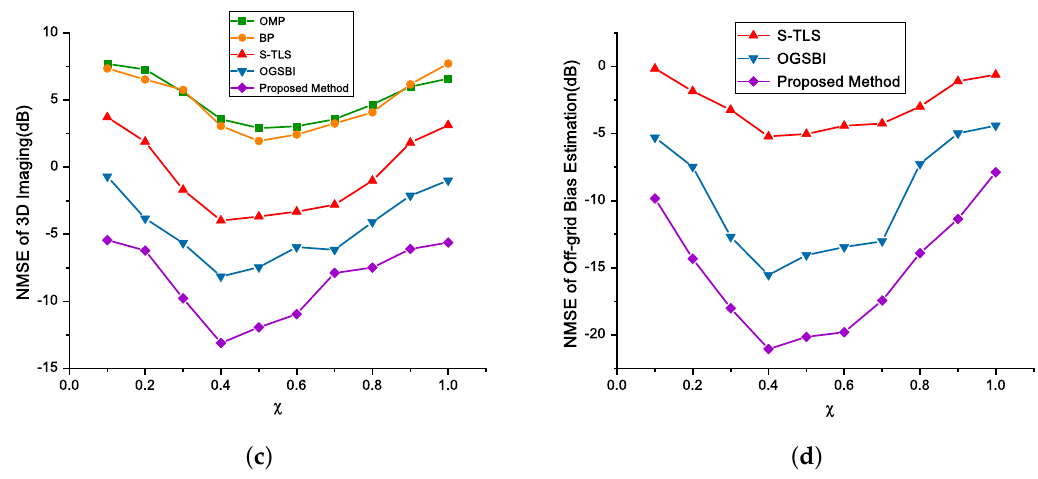
Figure 5. NMSEs versus different SNRs and grid invervals: ( a ) NMSEs of 3D reconstruction versus different SNRs; ( b ) NMSEs of off-grid bias estimations versus different SNRs; ( c ) NMSEs of 3D reconstruction versus different grid intervals; ( d ) NMSEs of off-grid bias estimations versus different grid intervals.